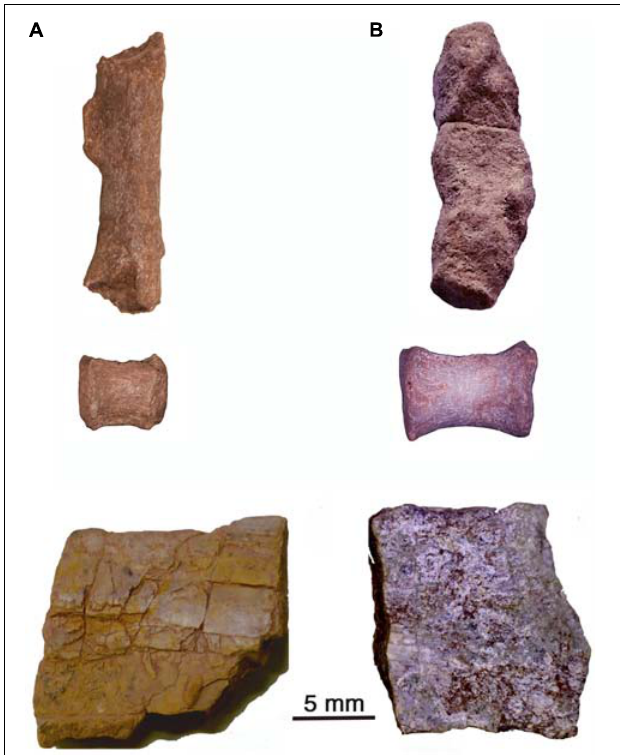
FIGURE 2 | Fossil materials that were available for this study. (A) Embryonic femur and a caudal centrum (not used for chemical analyses), and adult femur fragment of Lufengosaurus . (B) Embryonic limb bone inside a concretion and a dorsal centrum (not used for chemical analyses), and adult femur fragment of